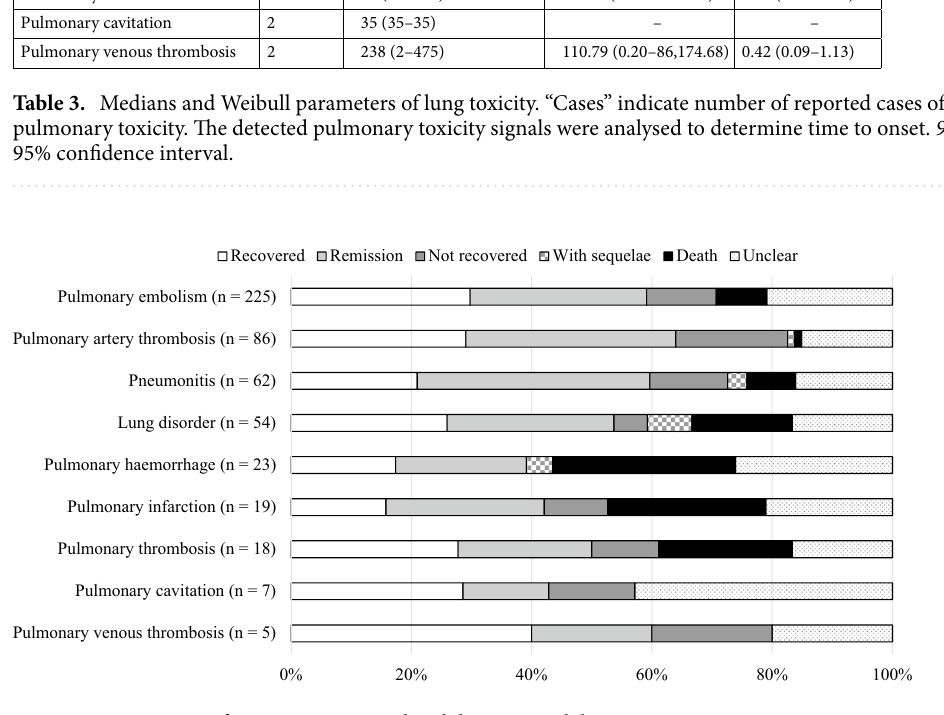
Figure 3. Percentage of nine AEs associated with bevacizumab by